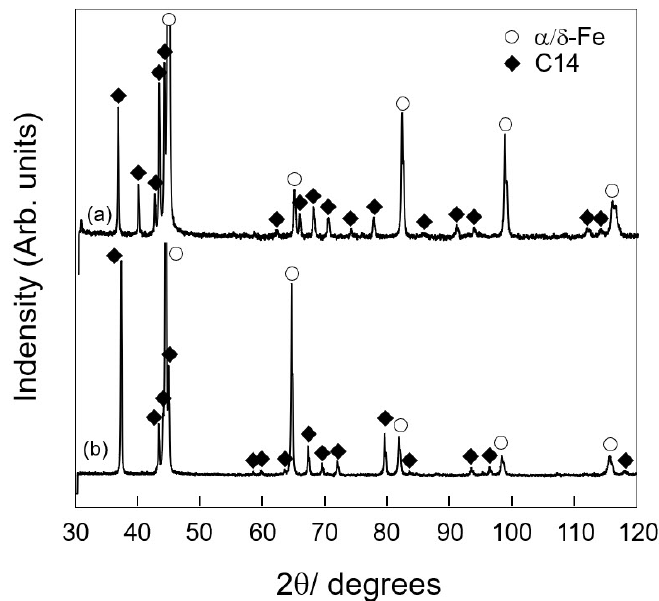
Figure 2. XRD profiles obtained from the 4 Hf and 5 Ta alloys: ( a ) 4 Hf alloy heat-treated at 1150 °C for 48 h, ( b ) 5 Ta alloy heat-treated at 1100 °C for 235 h.